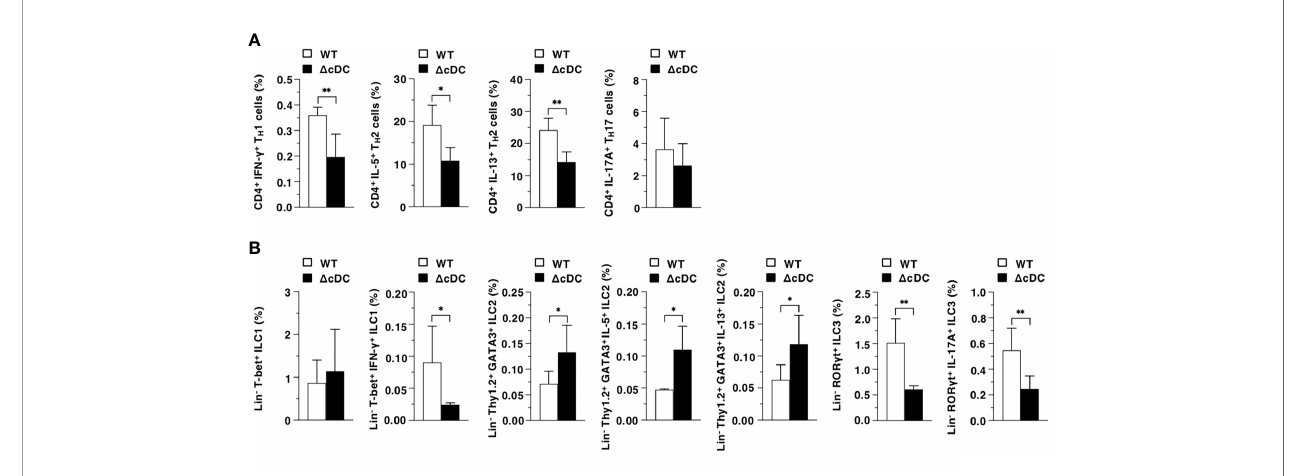
FIGURE 4 | Constitutive loss of cDCs reciprocally controls the composition of CD4 + T eff cells and ILCs during onset of AD-like in fl ammation. The frequency of the subsets of T cells (A) and ILCs (B) in EDLNs obtained from WT mice and D CD11c hi cDC mice (n = 6 per group) at 16 days after topical application with MC903. Data are obtained from six individual samples in a single experiment. * P < .05, ** P < .01 compared with WT mice by two-sided paired student t -test. All data are representative of at least 3 independent